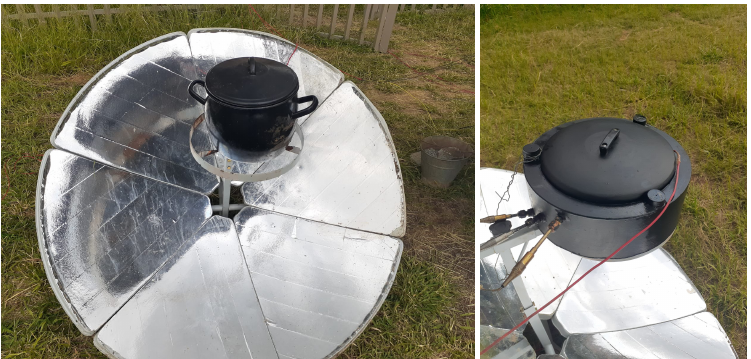
Figure 1. Photograph of the experimental setup for validation of the numerical model. ( Left ) parabolic mirror with pot in the centre and ( Right ) cooking pot with thermocouples